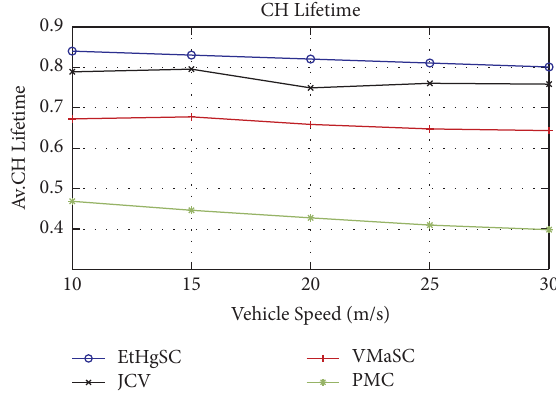
Figure 9: Average CH lifetime at diferent speeds.